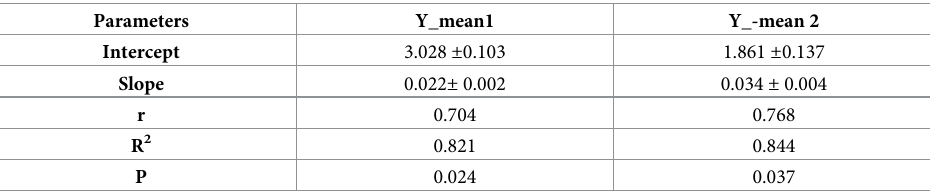
Table 4. Regression analysis of EDA signal parameter